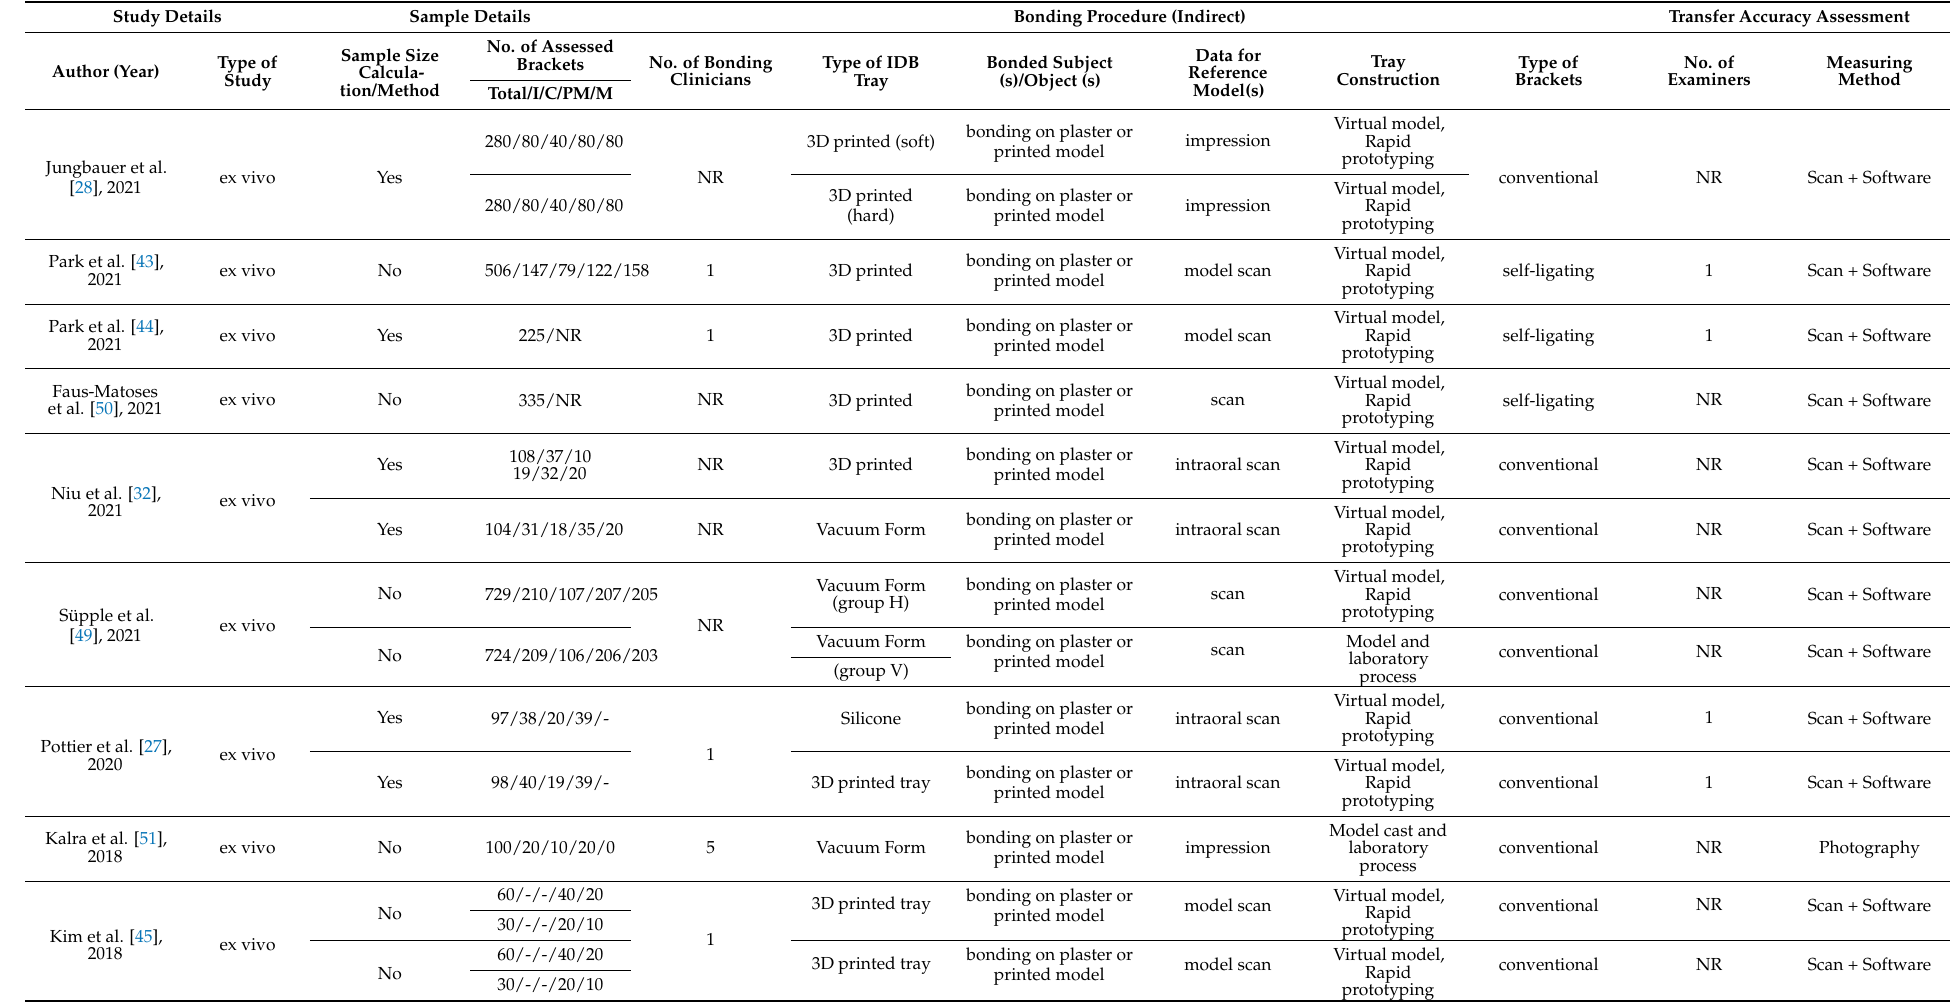
Table 3. Study characteristics of the included